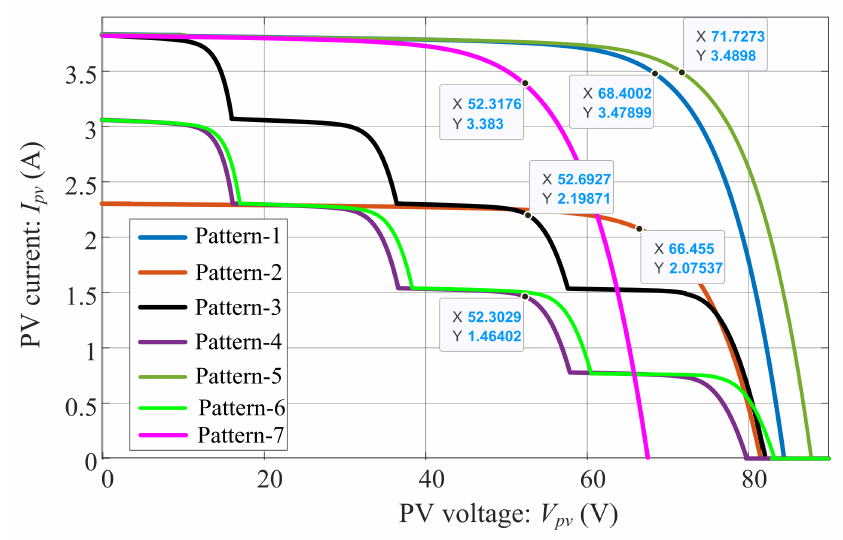
Figure 8. I–V graph for different shading patterns.